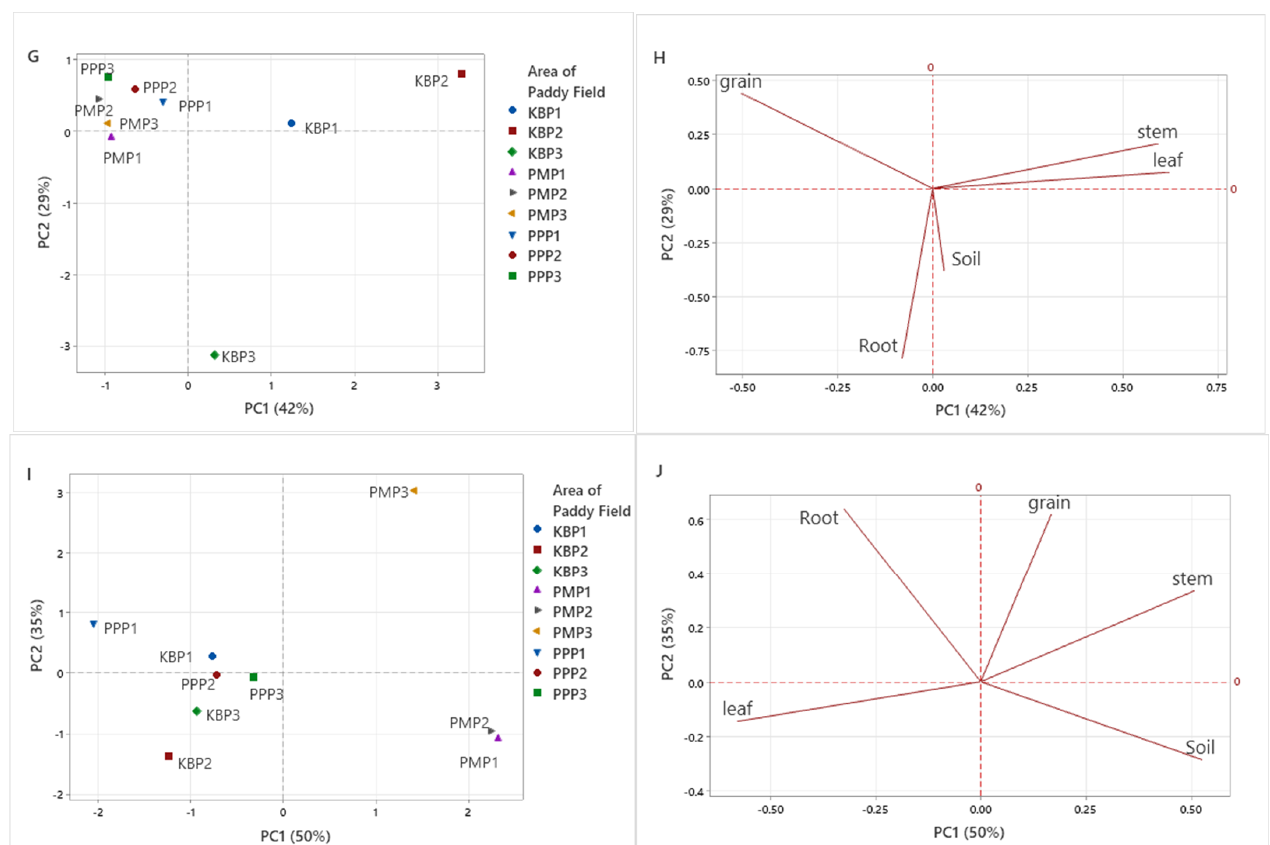
Figure 3. PCA score and loading plots showing the clustering pattern of different sampling sites based on the heavy metal concentration in paddy soil and paddy plant parts. ( A , B ) Score and loading plots of arsenic concentration, ( C , D ) cadmium concentration, ( E , F ) lead concentration, ( G , H ) copper concentration and ( I , J ) chromium concentration in different sam- pling